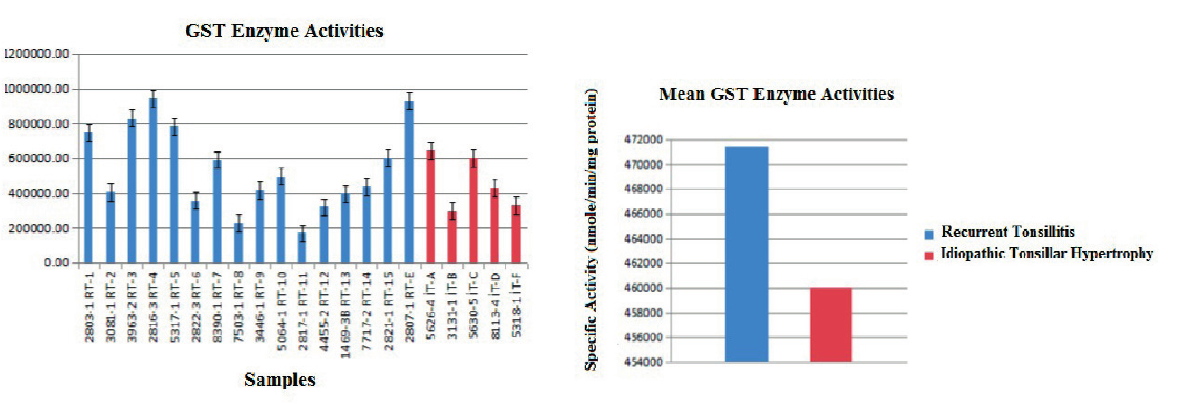
Fig. 2. The distribution of mean GST activity among the groups ( P >0.050).